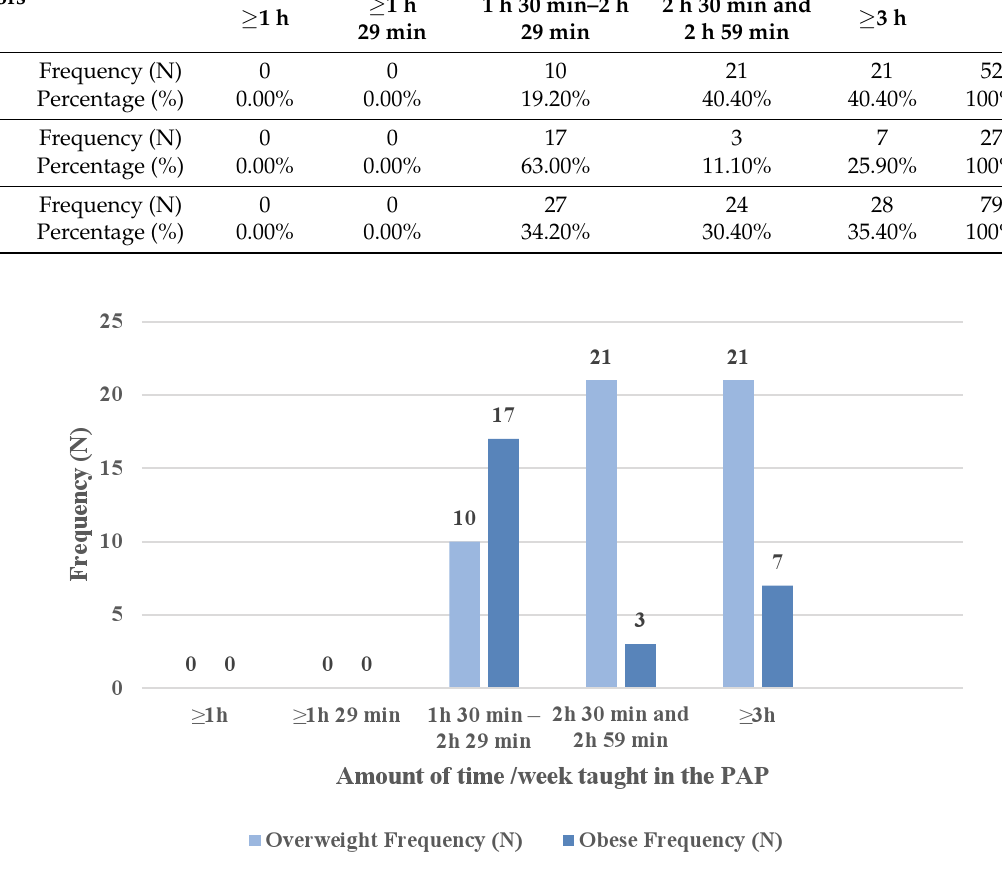
Figure 2. Distribution of total weekly time spent on physical activity.